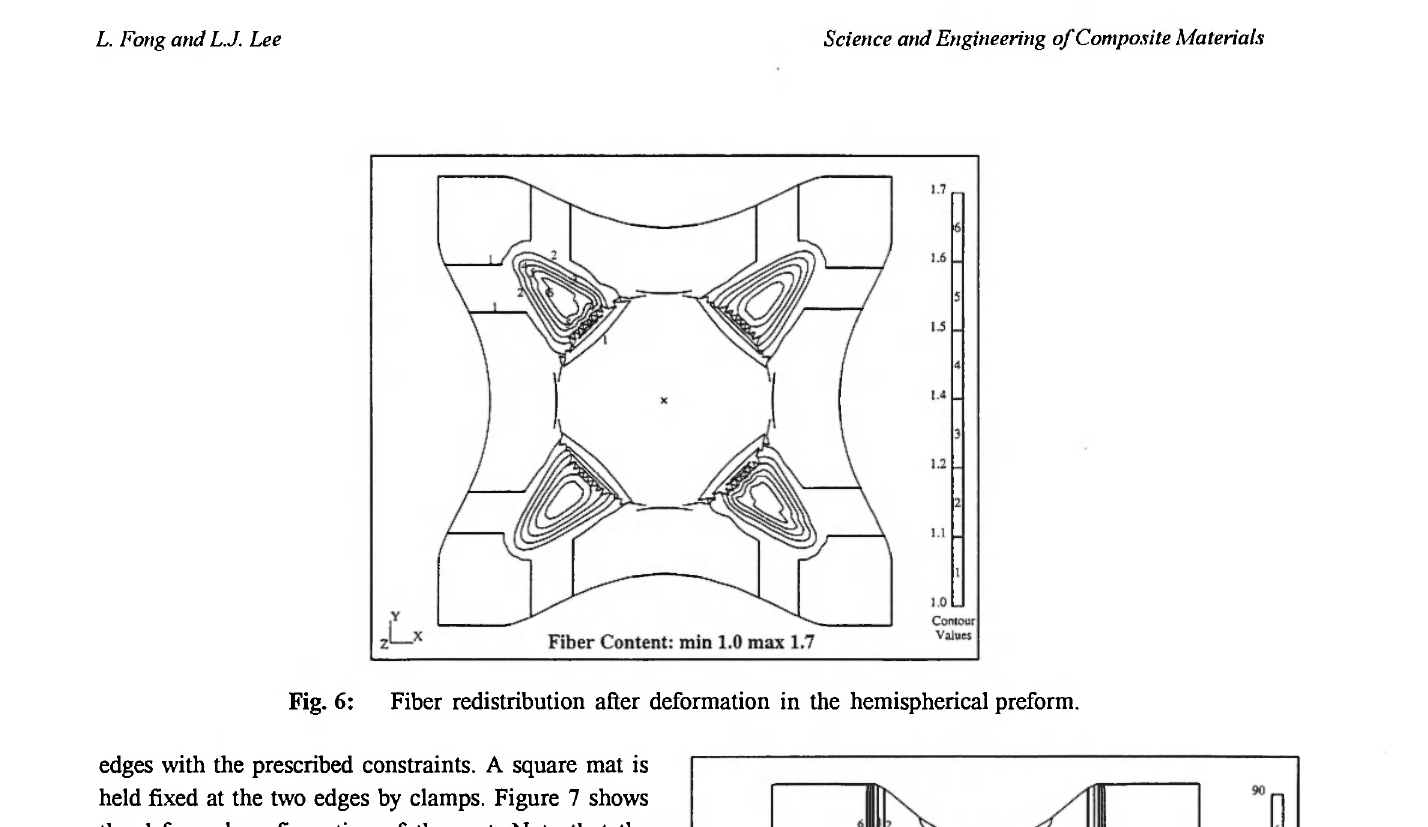
Fig. 6: Fiber redistribution after deformation in the hemispherical preform. edges with the prescribed constraints. A square mat is held fixed at the two edges by clamps. Figure 7 shows the deformed configuration of the mat. Note that the material was drawn inward at the two free edges while the constrained edges remain fixed by the clamps. A comparison between the two cases with and without edge clamping shows that the minimum shear angle achieved by edge clamping is less severe as illustrated in Figure 8. The minimum shear angle attained has